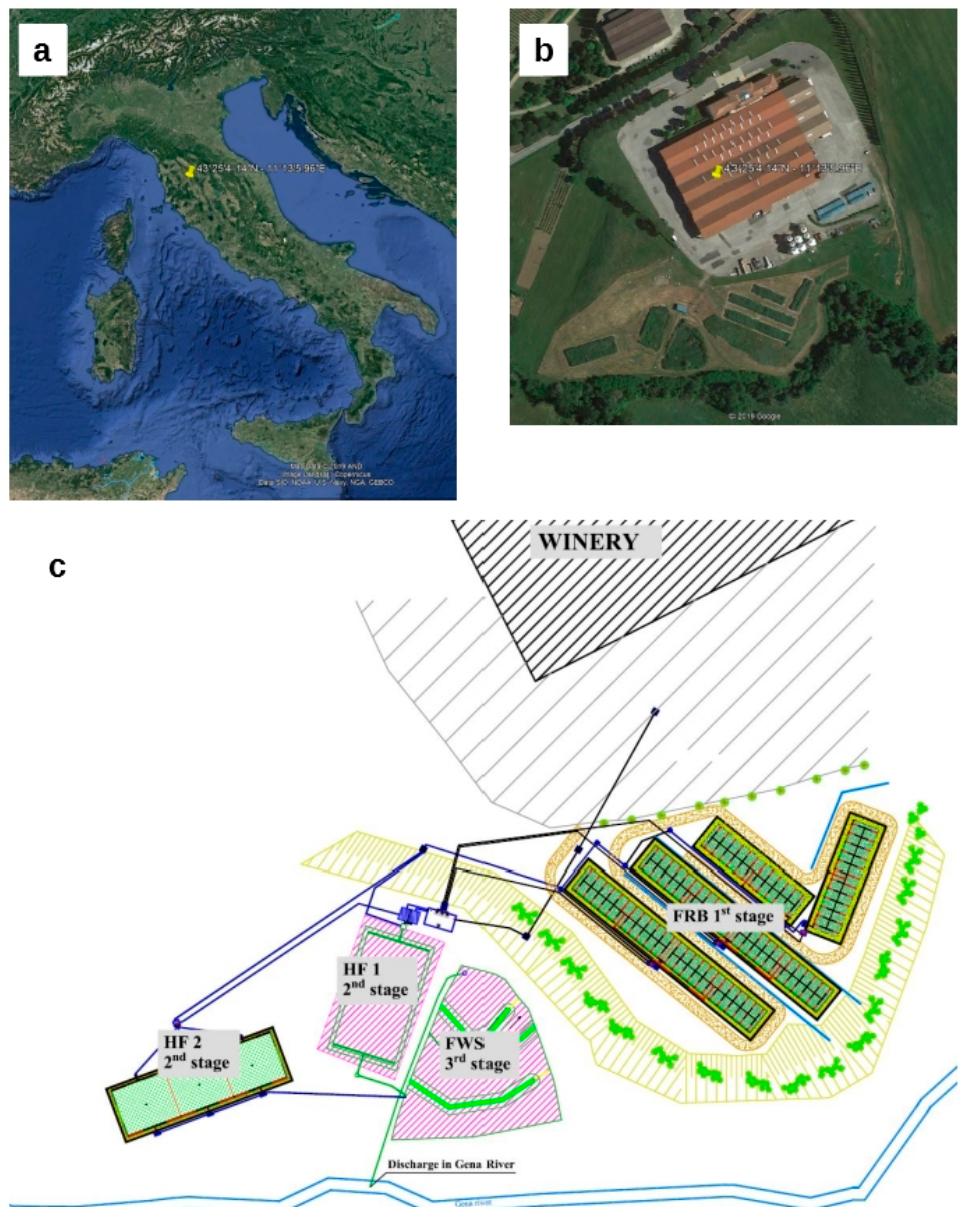
Figure 1. Constructed Wetlands (CW) wastewater treatment plant (WWTP) serving the Cecchi winery (Castellina in Chianti, Italy): ( a ) position; ( b ) aerial view; ( c ) planimetry, in which the stages in magenta represent the CW beds refurbished horizontal subsurface flow systems (HF) and recovered free water system (FWS) from the original CW WWTP of 2001.